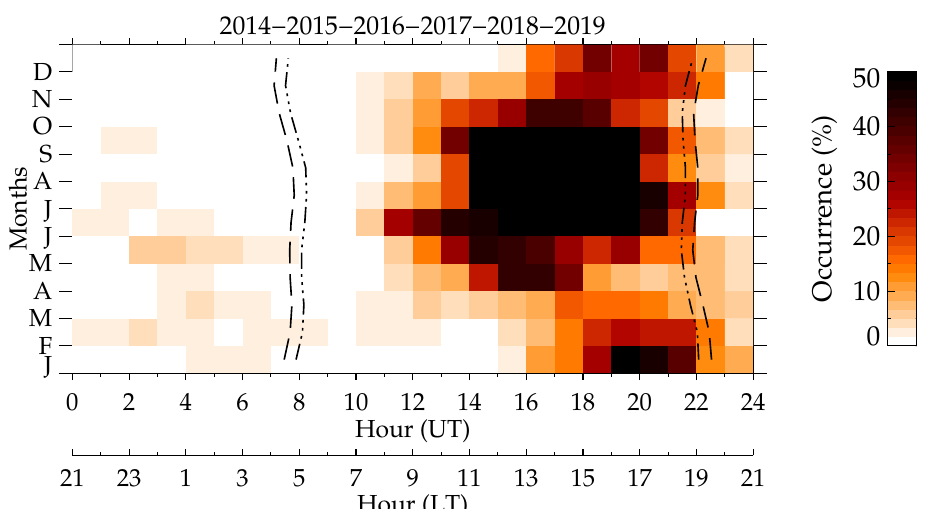
Figure 11. Time dependence and seasonal variation of the occurrence of MSTIDs observed over the South American equatorial region from January 2014 to December 2019. The months are represented by their initials and the dawn and dusk solar terminator are shown at the altitude of 100 km (dotted lines) and 300 km (broken